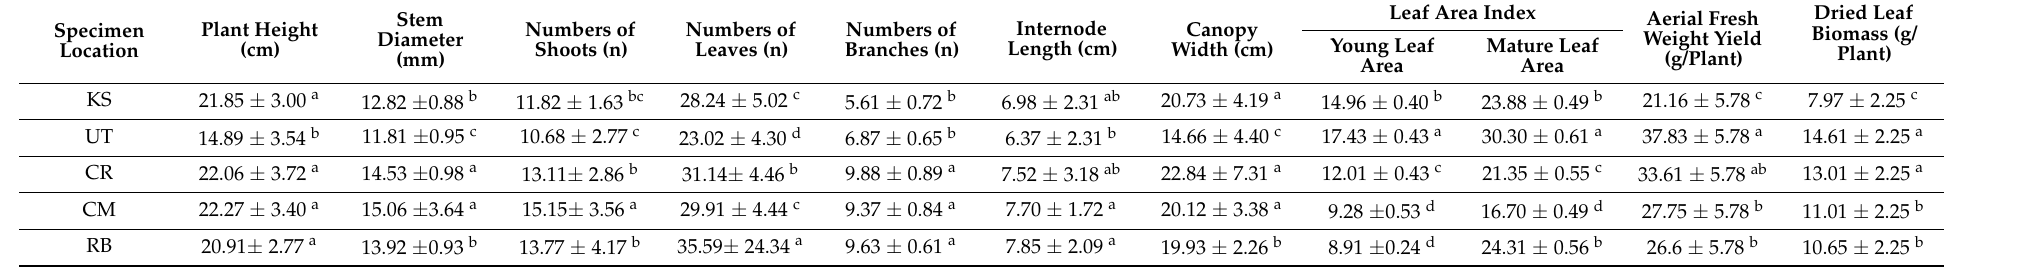
Table 1. Physiological characteristics of Andrographis paniculata collected from various locations.